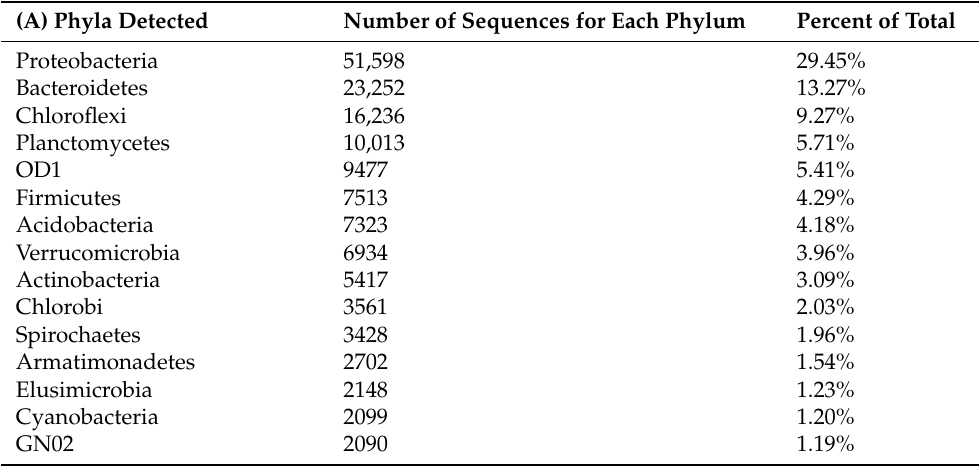
Table A2. ( A ) Number of sequences and the percent of total (more than 1% of total shown) for some detected phylum in nutrient and metal